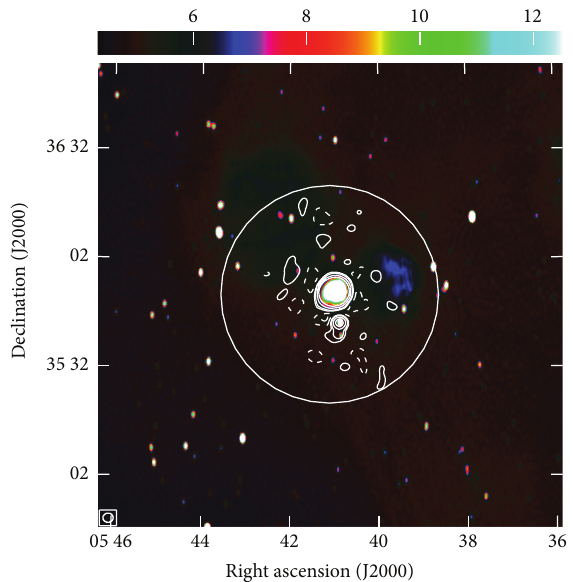
Figure 3: AME-G173.6+2.8: AMI SA data is shown as contours over CGPS 1.4 GHz pseudo colour, in brightness temperature. The pseudo-colour scale is truncated at 12.5K ( ≃ 0.25 × peak brightness of S235) to show the low-surface-brightness diffuse structures. on the AMI map AMI contours are at ± 5, 10, 25, and 50 𝜎 rms (1.77mJybeam −1 ). The 1 ∘ Planck smoothing scale is shown as the large circle, and the AMI SA synthesised beam is shown in the bottom left